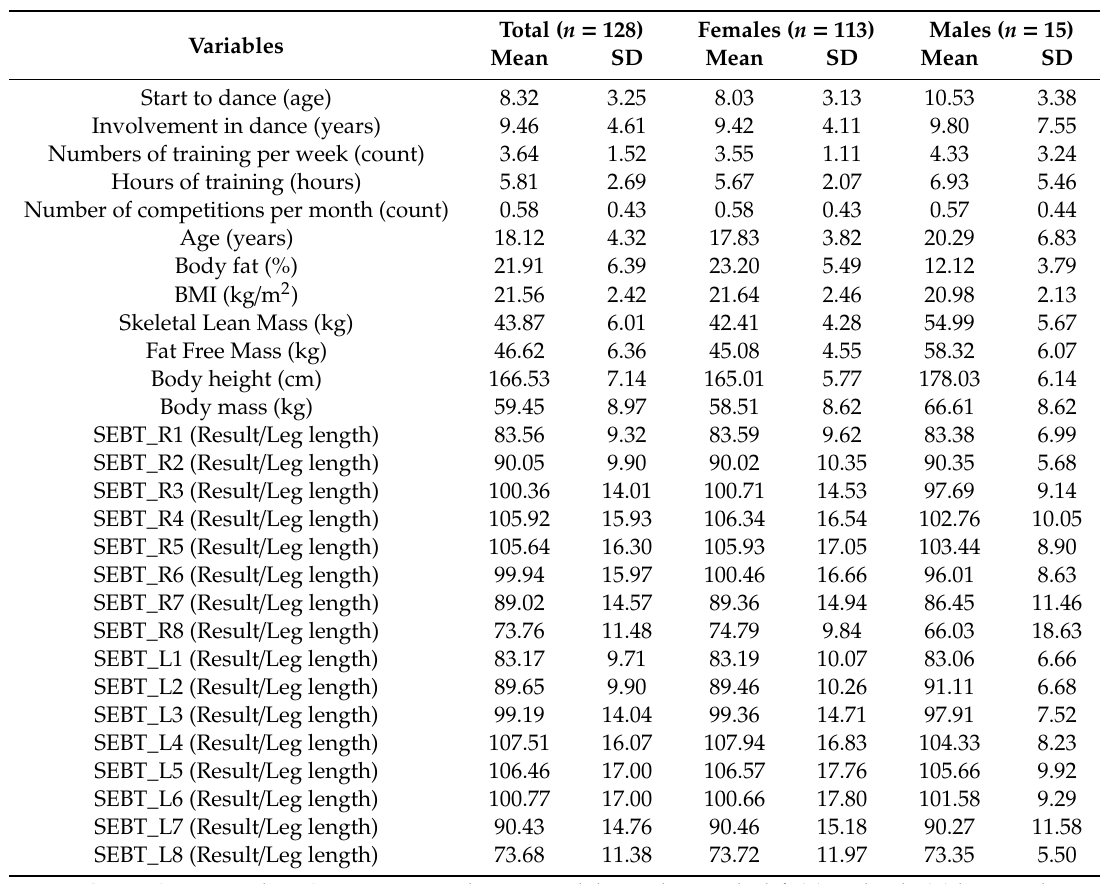
Table 1. Descriptive statistics for studied dance factors, anthropometric and body build indices, and balance performance in hip hop dancers.